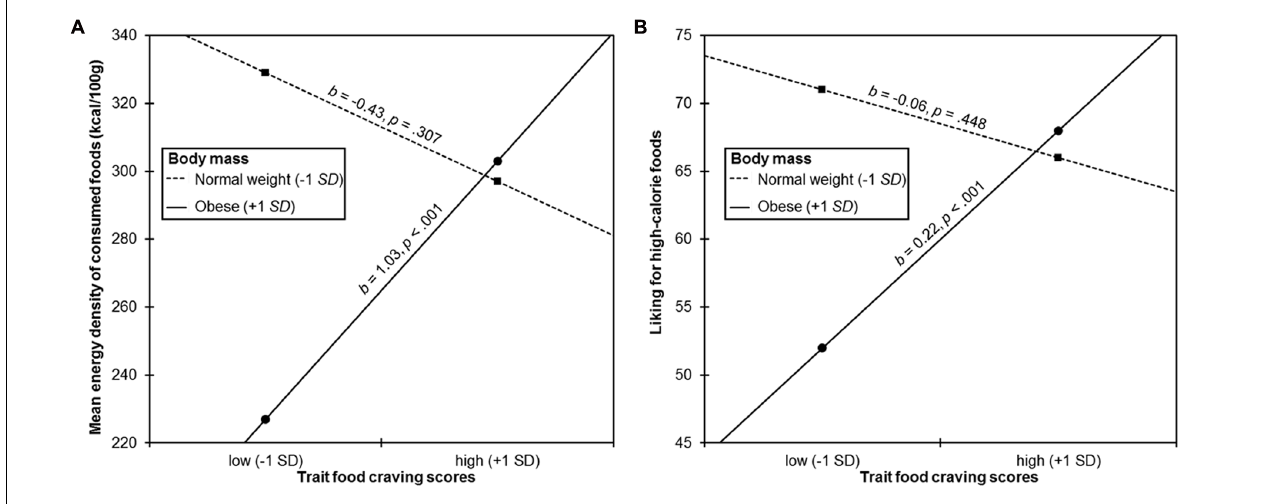
FIGURE 2 | Simple slopes probing the interaction between trait food craving scores and body mass when predicting (A) mean energy density of consumed foods and (B) liking for high-calorie foods. Trait food craving scores positively predicted mean energy density of consumed foods and liking for high-calorie foods in obese participants ( + 1 SD of mean standardized body mass index), but not in normal-weight participants ( − 1 SD of mean standardized body mass index).